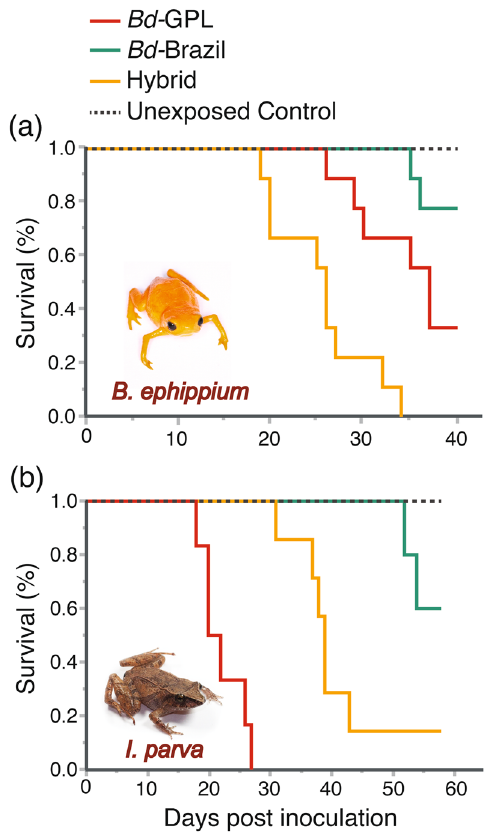
Figure 1. Survival curves for Brachycephalus ephippium ( a ) and Ischnocnema parva ( b ) exposed to Bd -GPL, Bd - Brazil and hybrid genotypes. Dashed line depicts unexposed control